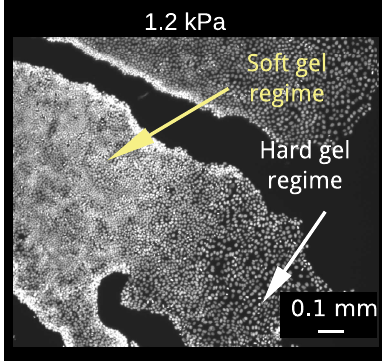
FIG. 8. Tissues grown on soft gels with stiffness of 1.2 kPa. For slightly higher stiffness than 0.6 kPa, typically in the range of 1 kPa to 3 kPa, the tissue exhibits the behaviors expected on both soft gels and hard gels, as indicated on the picture by arrows. The image is from Ref.